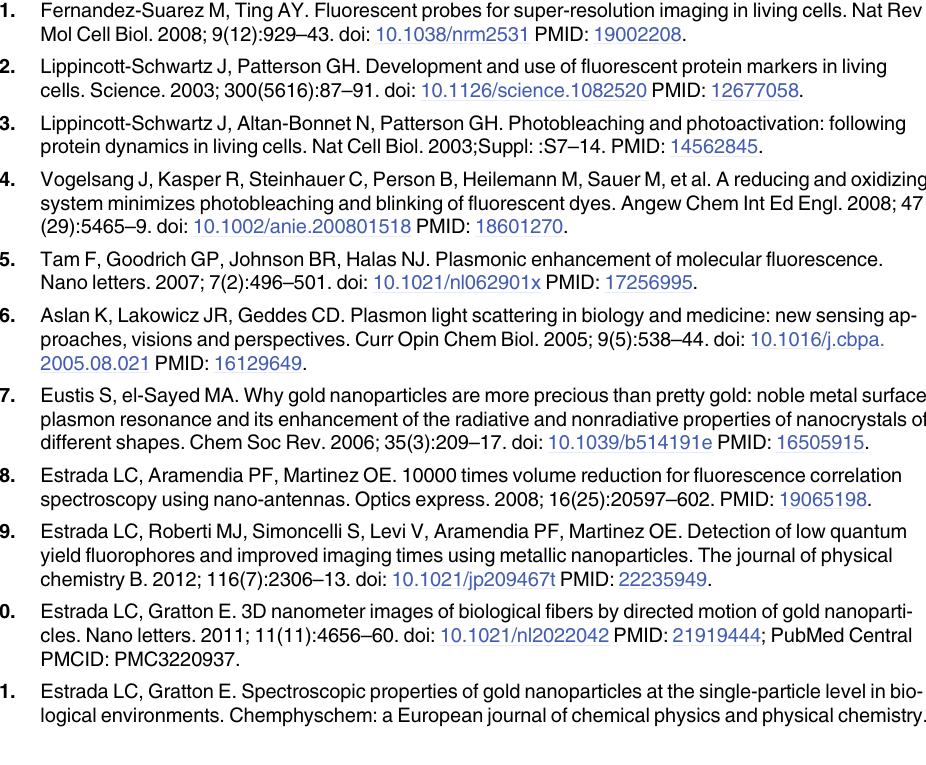
(TIF) S2 Fig. Fixed AuNP excited at 880nm. A) The average spectrum at all polarization angles. B) The fraction of the spectrum in the SHG region at 440 nm (red area) is larger in the quad- rant 0 – 90 and 180 – 270 degrees with respect to the emission in the region between 500 to 650nm (blue area) which is larger in the region between 90 – 180 and 270 – 360 degrees. (TIF) S3 Fig. Raster scan images of a single 200 nm beads fixed on a glass coverslip. The sample is excited at 790 nm with 3 different orientations of linear polarized light. The emission is collect- ed through a bandpass filter 520/30 nm.